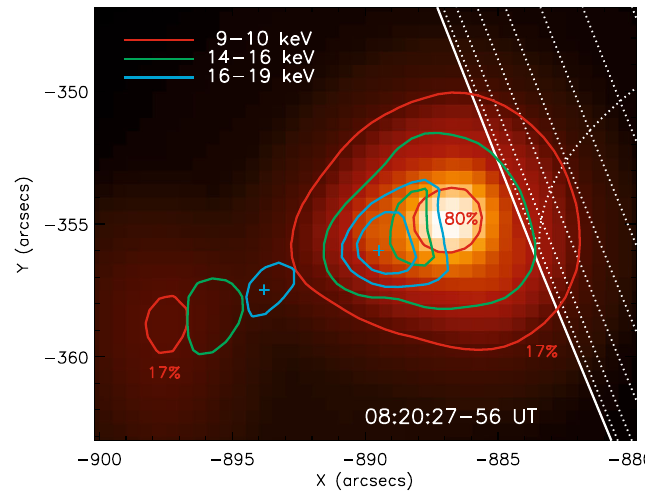
Fig. 17 RHESSI observations of the flare SOL2002-04-30 with soft X-ray emissions that extend beyond the loop top. The footpoints are occulted by the solar limb. In the lowest energy band (9–10 keV, red ) two contours are shown representing 17 and 80% of the maximum brightness. Image reproduced by permission from Liu et al. (2008), copyright by AAS